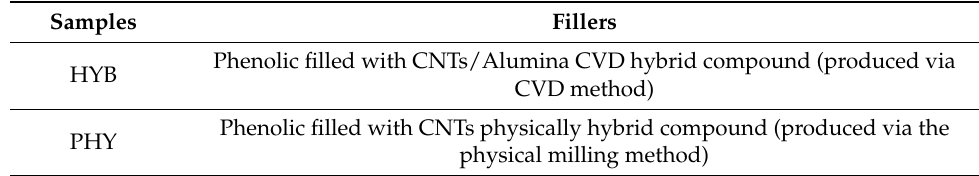
Table 2. Descriptions for sample HYB and PHY (1–5 wt% filler